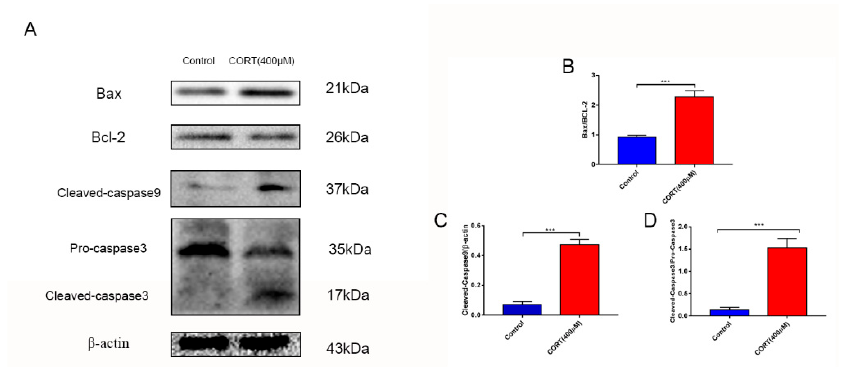
Figure 6. The relevant expression of apoptosis-related proteins in HT22 cell lysates after cortisol (CORT) treatment for 3 h as assessed by western blotting and relative density analysis ( A ) Bax, Bcl-2, cleaved caspase-9, caspase-3, and β -actin expression in each group. Expression levels were quantitated by measuring band intensities using Image Lab software. The graphs indicate densitometric analyses using the expression ratios of ( B ) Bax / cl-2, ( C ) cleaved caspase-9 / β -actin, and ( D ) cleaved-caspase-3 / procaspase-3. Data were between control (CORT 0 µ M) vs. CORT (400 µ M), and were analyzed by one-way analysis of variance. The results are expressed as the mean ± SD ( n = 3) in each independent. NS: not significant; *** p < 0.001.